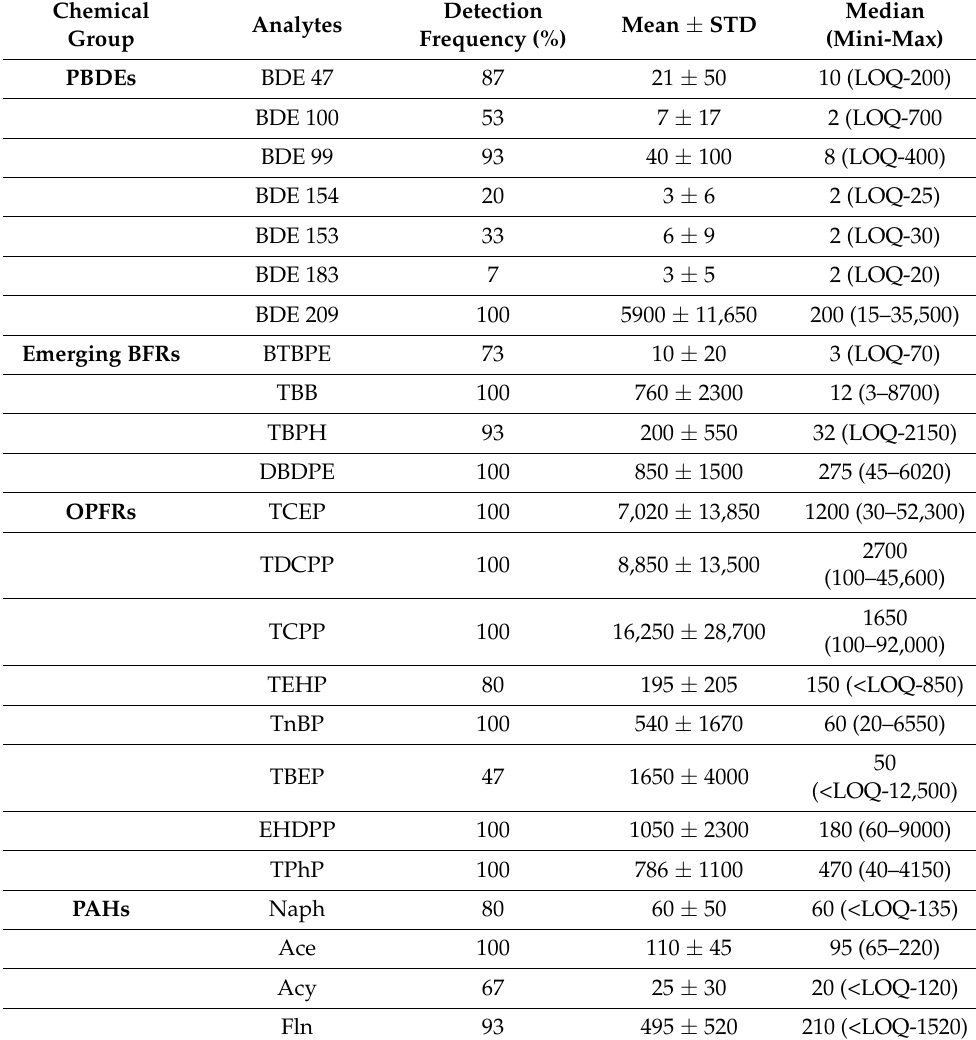
Table 2. Descriptive statistics of analyzed chemicals in Saudi car dust ( n = 15). All values are given in ng/g of